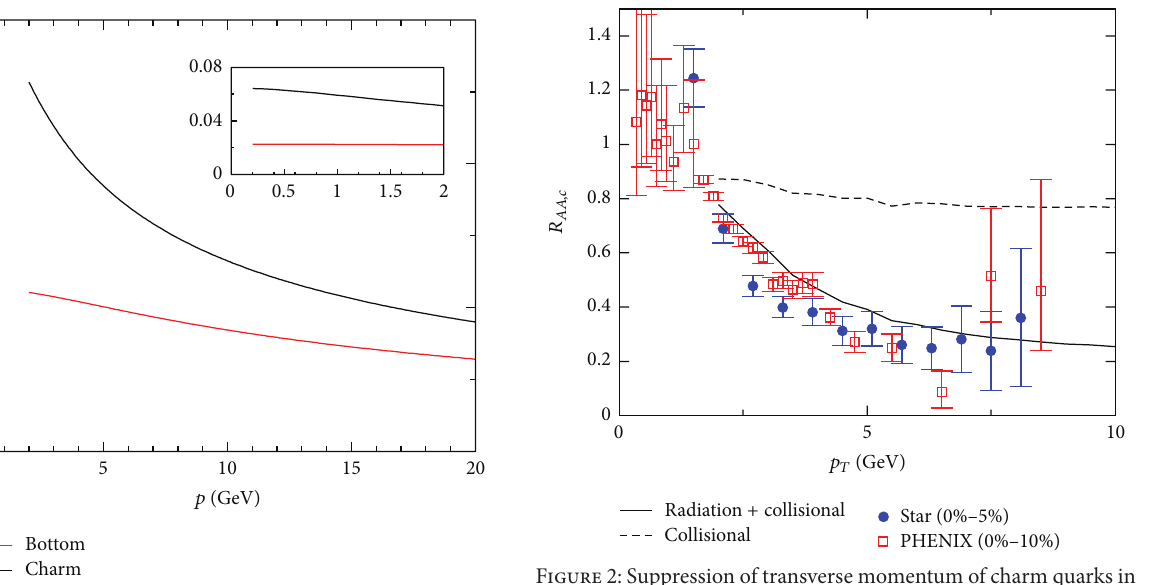
Figure 1: Drag coefficients of charm and bottom with their momen- tum at 𝑇 = 300 MeV assuming running strong coupling, 𝛼 𝑠 (𝑇) , and temperature-dependent Debye screening mass, 𝑚 𝐷 (𝑇) for gluon, quark, and antiquark scattering.